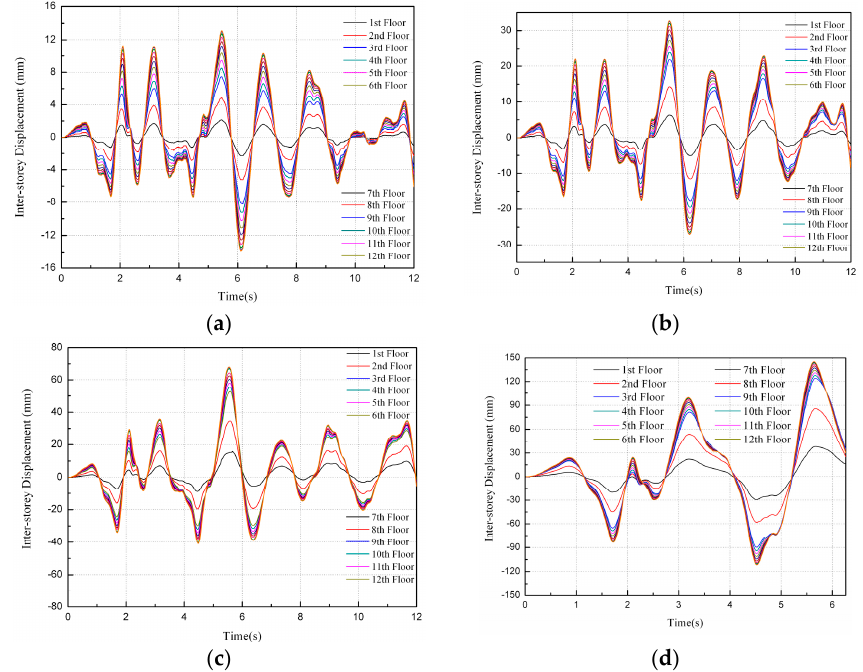
Figure 18. Time history curves of story drift with different peak accelerations: ( a ) 35 gal; ( b ) 70 gal; ( c ) 110 gal; ( d ) 220 gal.